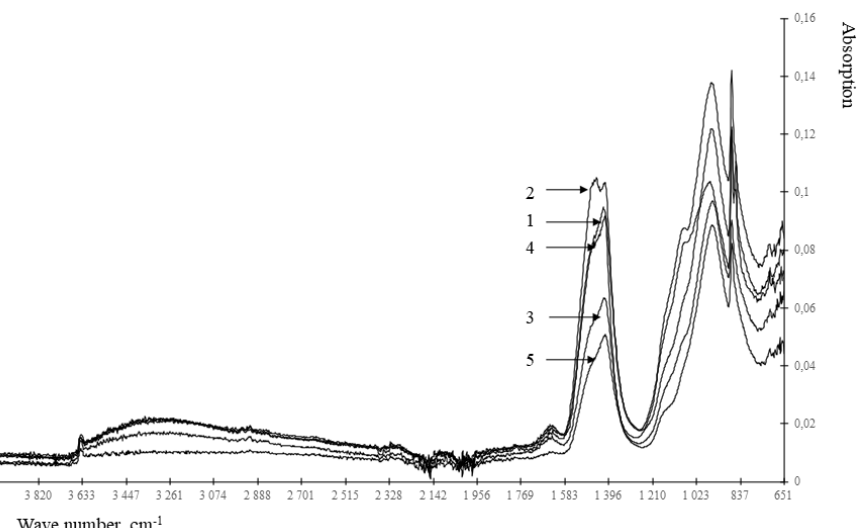
Figure 3. IR spectra of cement stone modified with barium hydrosilicates and copper hydrosilicates (0.5%): 1—at the age of 1 day; 2—at the age of 3 days; 3—at the age of 7 days; 4—at the age of 14 days; 5—at the age of 28 days.